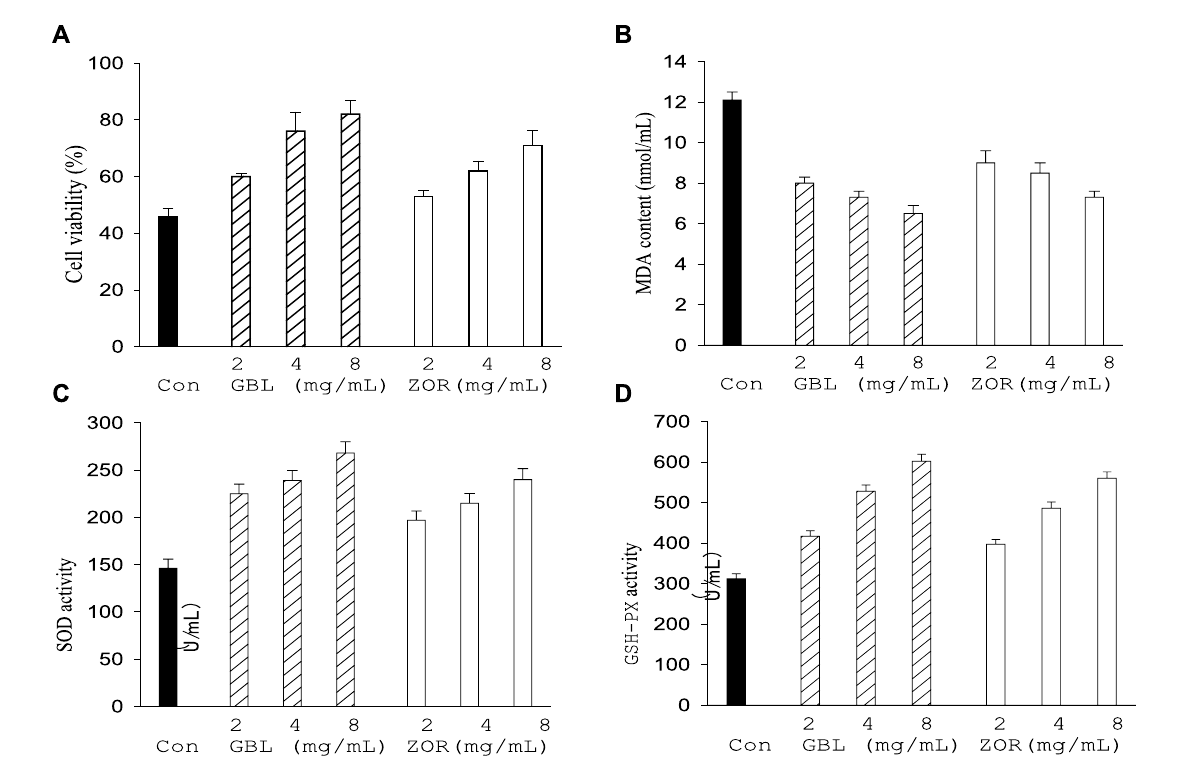
FIGURE 6 Effect of G. biloba leaf (GBL) and Z. of fi cinale rhizome extracts (ZOR) from Yongzhou on central neuron cell viability (A) and serum antioxidant indexes (B – D) in aged mice.